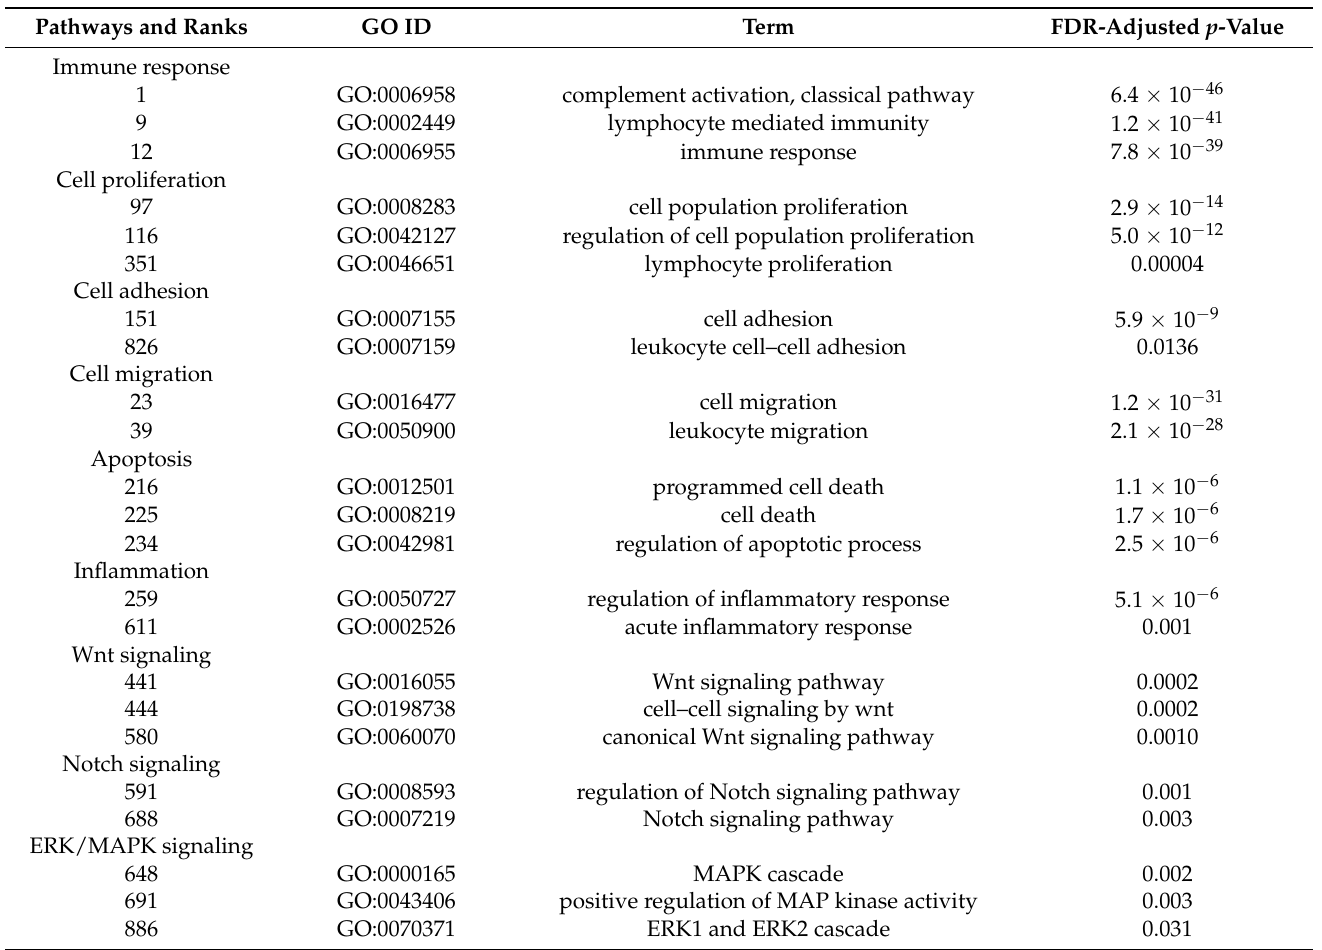
Table 3. Selected enriched pathways reported by gene ontology (GO) analysis of differentially expressed genes identified through meta-analysis of gene expression profiles of CD4+ T cells infected with HIV-1 in vivo. Pathways and